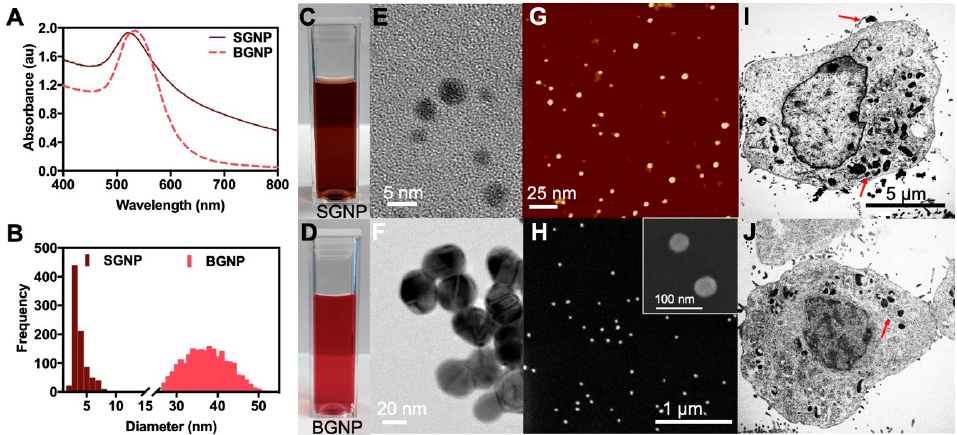
Figure 1. ( A ) Absorbance spectra of the small (SGNP) and big (BGNP) gold nanoparticles with an absorbance maxima occurring around 519 nm and 534 nm, respectively. ( B ) Size distributions of SGNP (average particle size of 3.86 ± 1.27 nm) and BGNP (average particle size 37.39 ± 5.52 nm) for over 300 particles. Optical micrograph of ( C ) SGNP and ( D ) BGNP. TEM images of ( E ) SGNP and ( F ) BGNP. ( G ) AFM image of the SGNP and ( H ) SEM image of the BGNP. ( I ) SGNP and ( J ) BGNP internalized in LLC cells. Red arrows highlight particle clusters within the vacuoles of the cell.